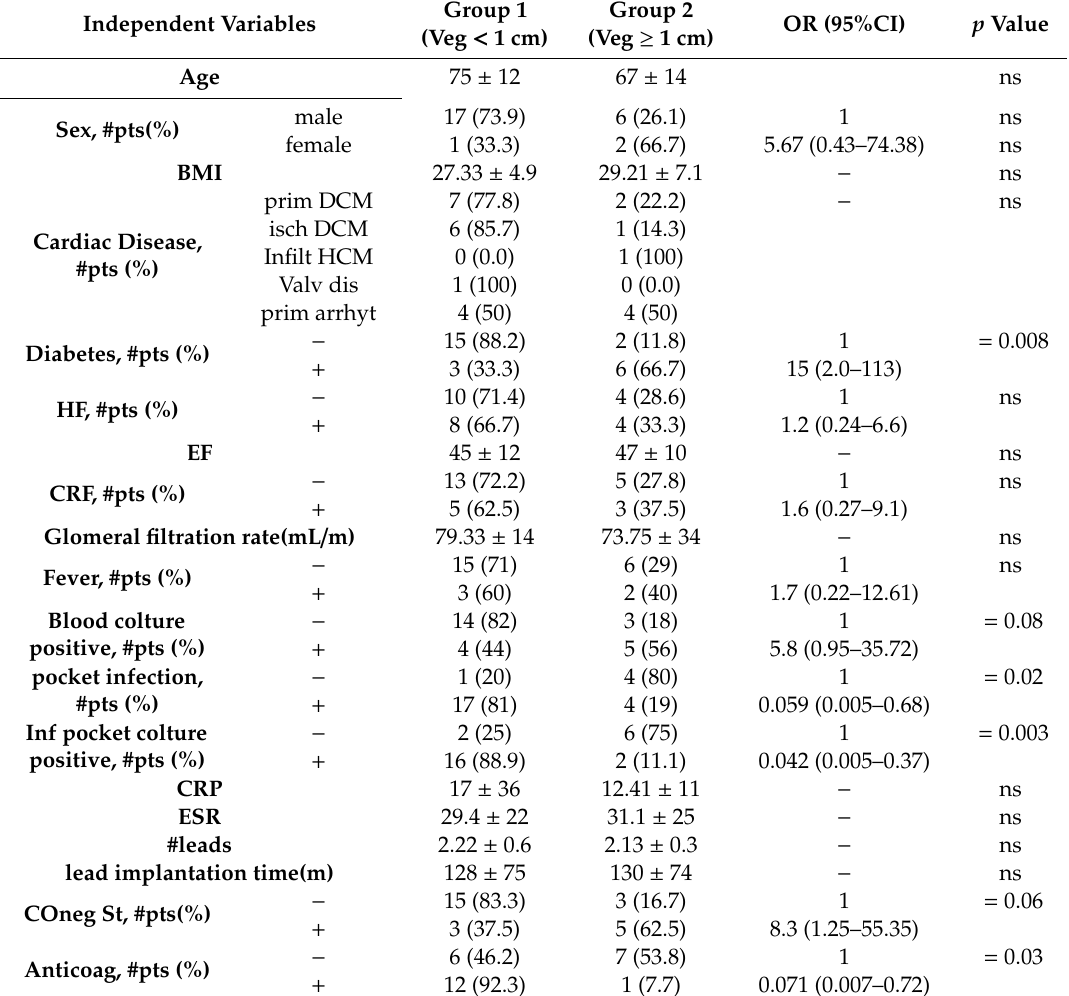
Table 1. Risk factors modulating lead vegetations size (univariate